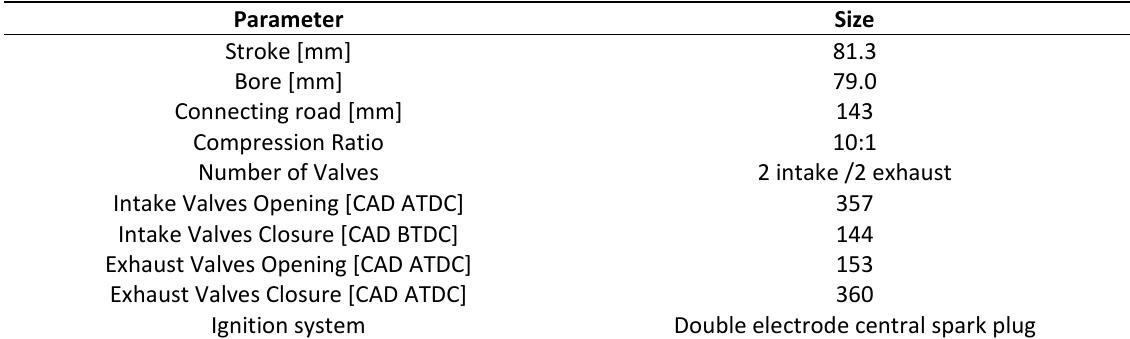
Figure 1 . Experimental set up installed to perform cycle resolved flame images. T able 1. Engine